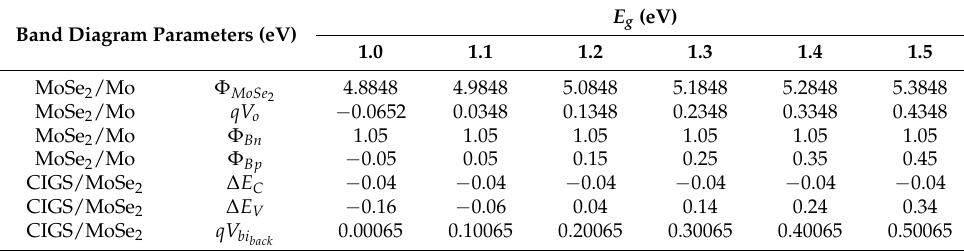
Table 4. Calculated Interface Electronic Parameters of Mo/MoSe 2 /CIGS in Various E g of MoSe 2 . Band Diagram Parameters